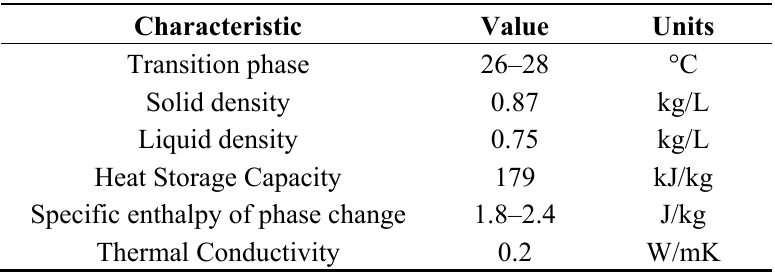
Table 1. Thermo-physical characteristics of the